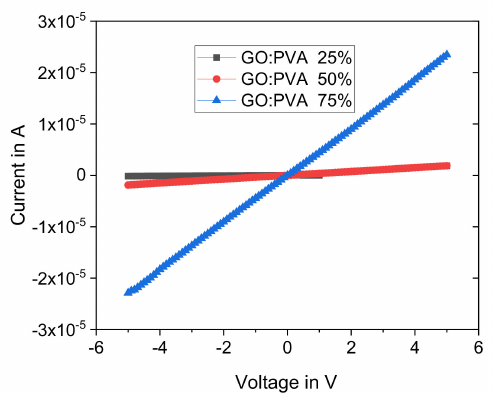
Figure 6. I-V measurement of GO / PVA with di ff erent ratios, deposited on glass substrate and annealed at 300 ◦ C. The measurements have been conducted by using a step of 0.1 V. The condition of GO:PVA at 50% was used for the realization of the layer on top of the proof mass of the sensor.